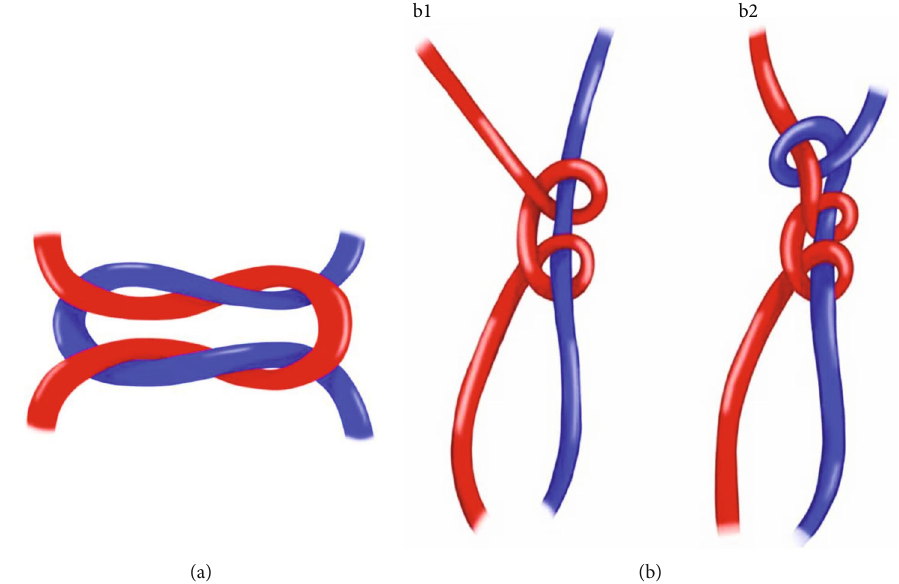
Figure 3: (a) Youn technique with 2-3 simple knots. (b) The Bergamaschi technique with the fi rst sliding knot (b1) and the second locking knot